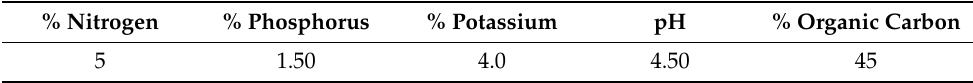
Table 2. Characteristics of the extracted organic